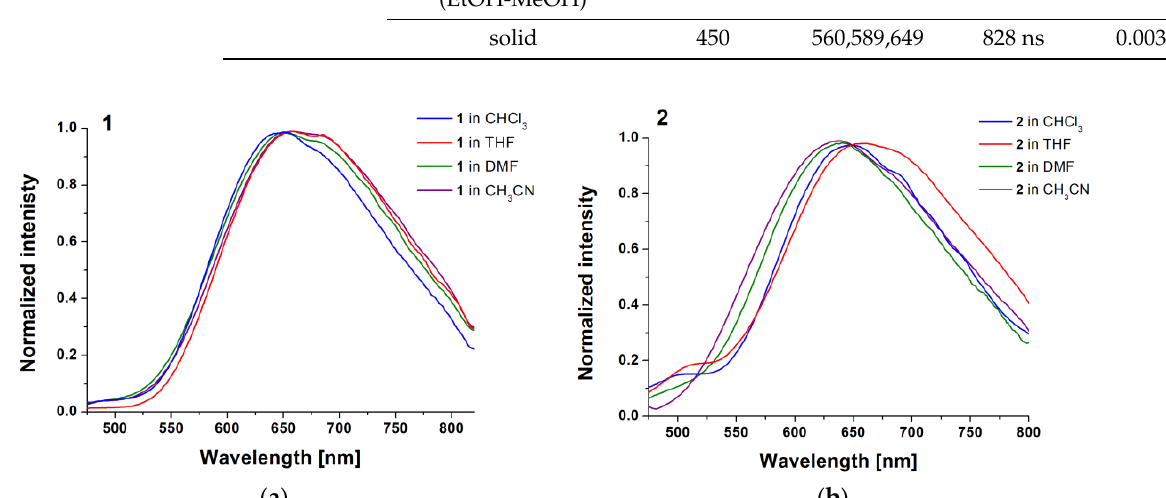
Figure 3. ( a ) Experimental (black line) absorption spectra of 1 alongside blue vertical lines present- ing singlet–singlet transitions with corresponding oscillator strengths, computed at TD- DFT/PCM/PBE1PBE/def2-TZVPD/def2-TZVP level with the use of the PCM model at polarities cor- responding to CH 3 CN and CHCl 3 ; ( b ) percentage composition of molecular orbitals for compound 1 computed at the DFT/PBE1PBE/def2-TZVPD/def2–TZVP level with the use of the PCM model at polarities corresponding to CH 3 CN and CHCl 3 . For complex 2 , see Figures S25–S27 in ESI.